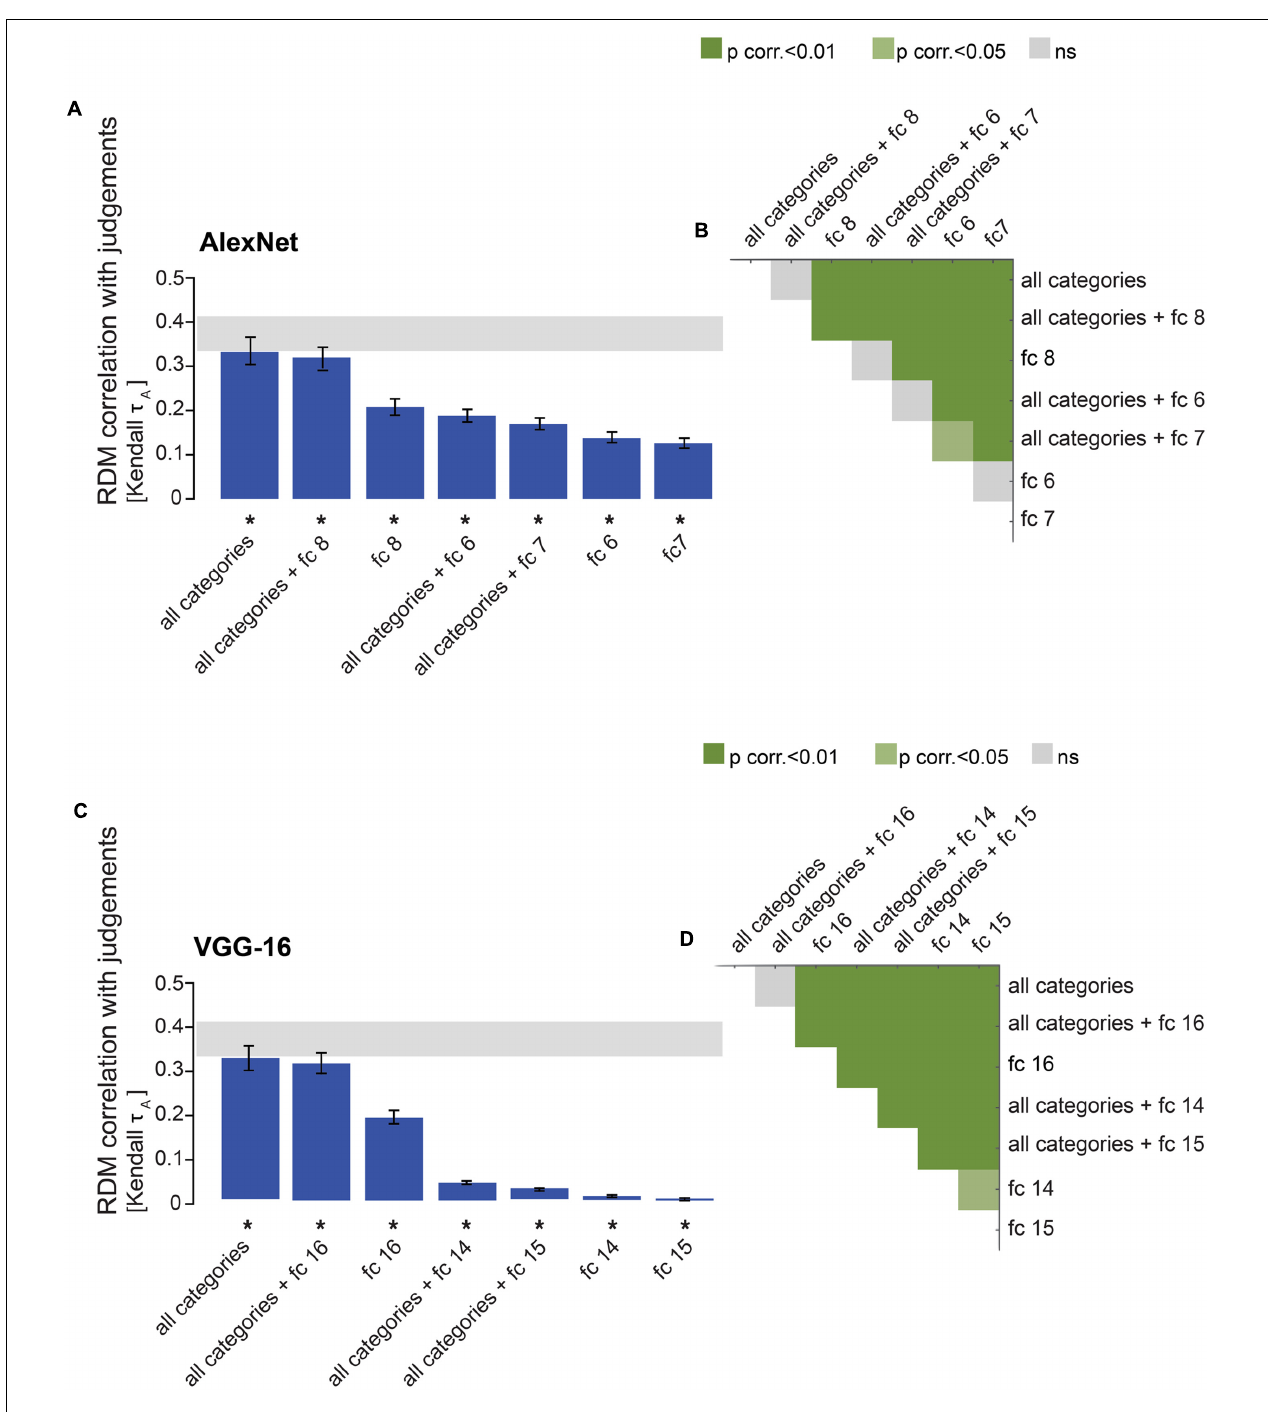
FIGURE 10 | Combining categorical models with late DNN layers: no improvement in model performance. (A) Bars show the correlation between the similarity-judgment RDMs and predictions of the fitted “all categories” model, the fitted AlexNet fully-connected layers, and the fitted combined models. Noise ceiling and significant correlations are indicated using the conventions in Figure 4 . (B) Pairwise differences between model performance of fully-connected AlexNet layer RDMs on their own or combined with the “all categories” model RDM, using the same conventions as in Figure 4 . (C) Bars show the correlation between the similarity-judgment RDMs and predictions of the fitted “all categories” model, the fitted VGG-16 fully-connected layers, and the fitted combined models. Noise ceiling and significant correlations are indicated using the conventions in Figure 4 . (D) Pairwise differences between model performance of fully-connected VGG-16 layer RDMs on their own, or combined with the “all categories” model RDM, using the same conventions as in Figure 4 .